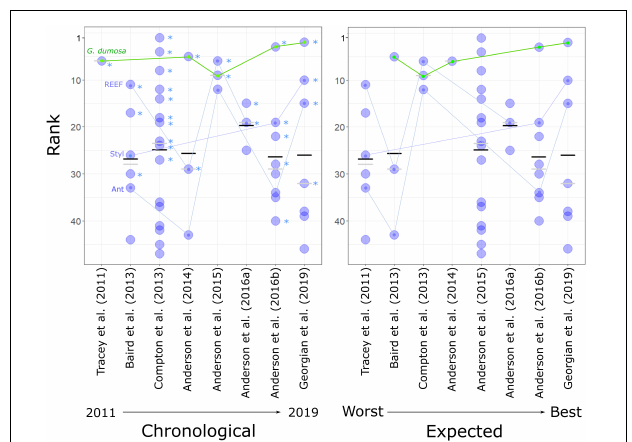
FIGURE 4 | Rank performance of 47 predictive models, showing average rank across four evaluation measures (TSS, t -test, R 2 prev , and R 2 dens ) for each model (blue dots), and the mean (black bars) and median (gray bars) ranking for each study (S1–S8). (Left) studies in chronological order, asterisks indicate models for which the average predicted probability of suitable habitat for the target taxon was significantly higher ( t -test, p < 0.01, “TS”) at sites where that taxon was present in the independent dataset than at those where it was absent. Four taxa that were modeled in more than two studies are linked by lines (see Figure 3 for full names). (Right) with studies ordered by their expected rankings as assessed by reference to the standards of Araujo et al.